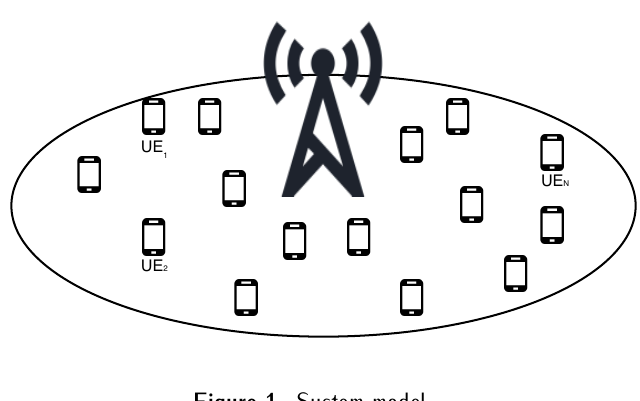
Figure 1. System